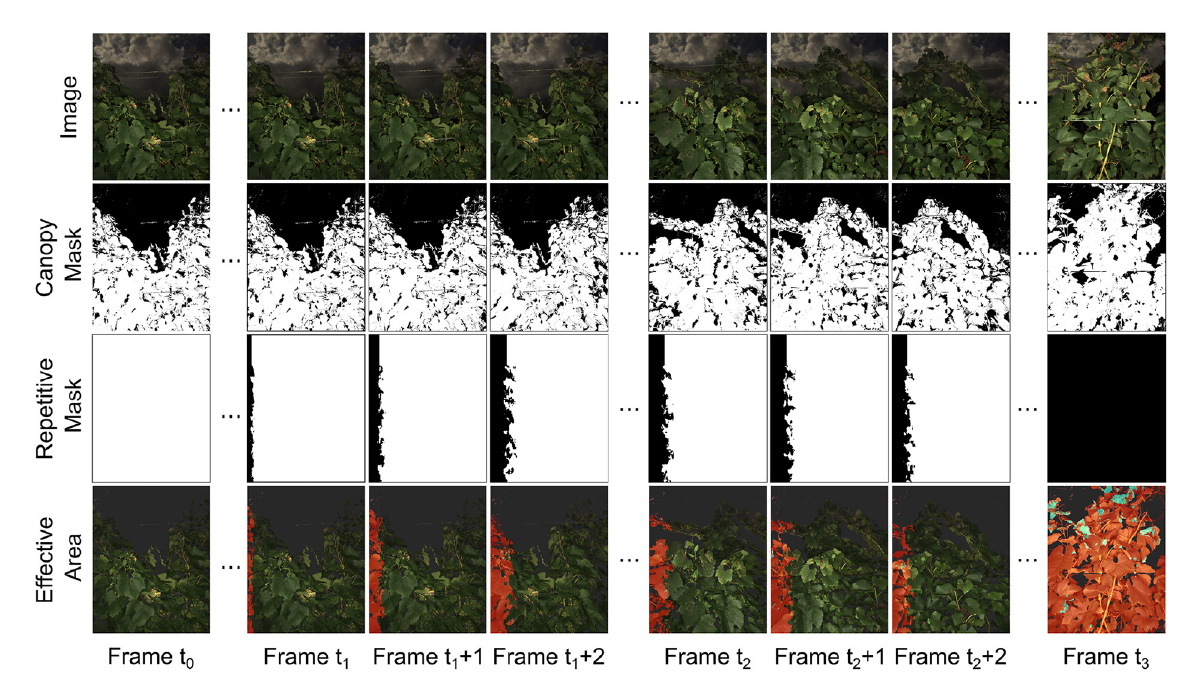
FIGURE7 Example masks for repetitive region removal. Data collection vehicle started from stop at t 0 and gradually accelerated from frame t 1 to frame t 1 + 2. The vehicle then moved with constant speed from frame t 2 to t 2 + 2. The vehicle moved out of the data collection region at frame t 3 . Canopies areas where the information was kept were labeled in red in effective area images. Infected regions within the effective areas were labeled in blue. The severity rate was determined by the sum of blue areas in the effective area images divided by the sum of red areas in the effective area images.